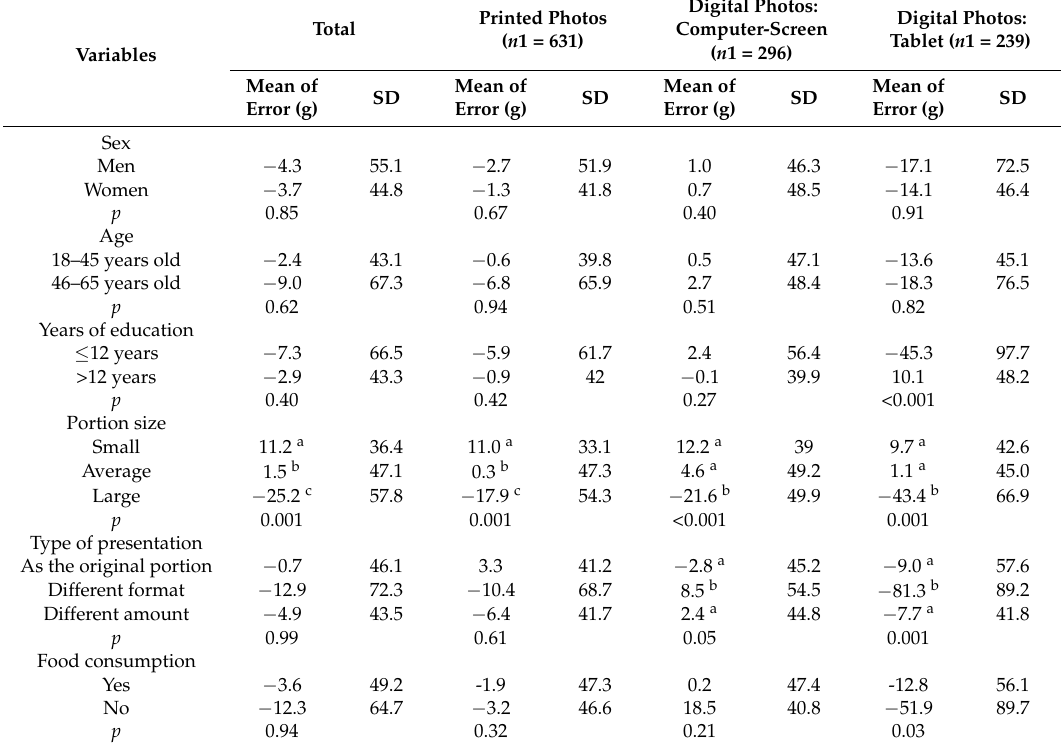
Table 3. Mean values and standard deviation of the total error of printed and digital photos, according to the characteristics of participants, portion size, type of presentation and consumption of foods ( n = 58 participants).